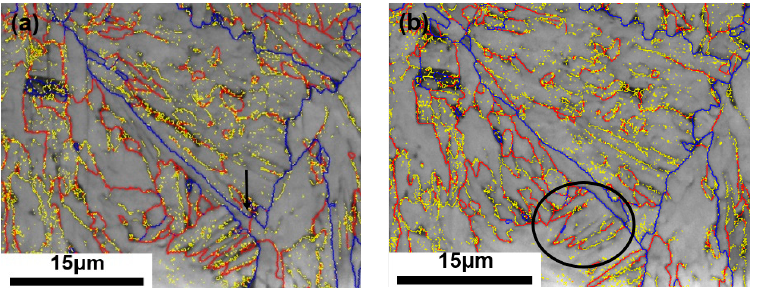
Figure 11. GB orientation of secondary Widmanstätten sideplates cutting process. ( a ) 62nd layer, ( b ) 72nd layer.